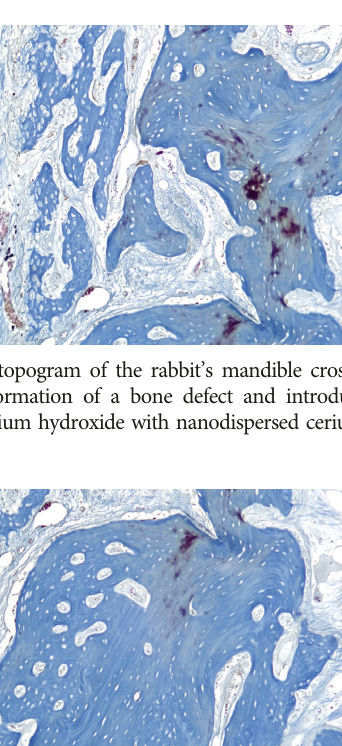
Figure 14: Histotopogram of the rabbit’s mandible cross section 4weeks after the formation of a bone defect and introduction of calcium hydroxide suspension with nanodispersed cerium dioxide.